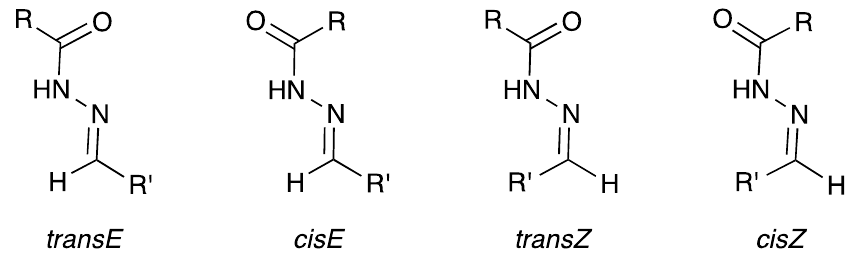
Figure 3. E/Z -configurational isomers and cis/trans amide conformers for N -acylhydrazones.